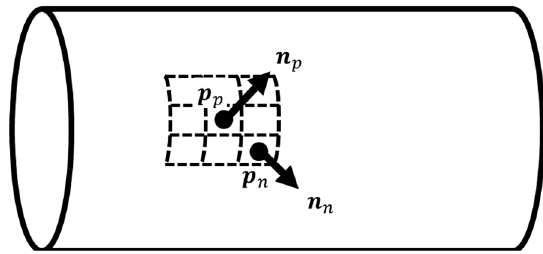
Fig. 4 Definitions and geometric relationships of position and